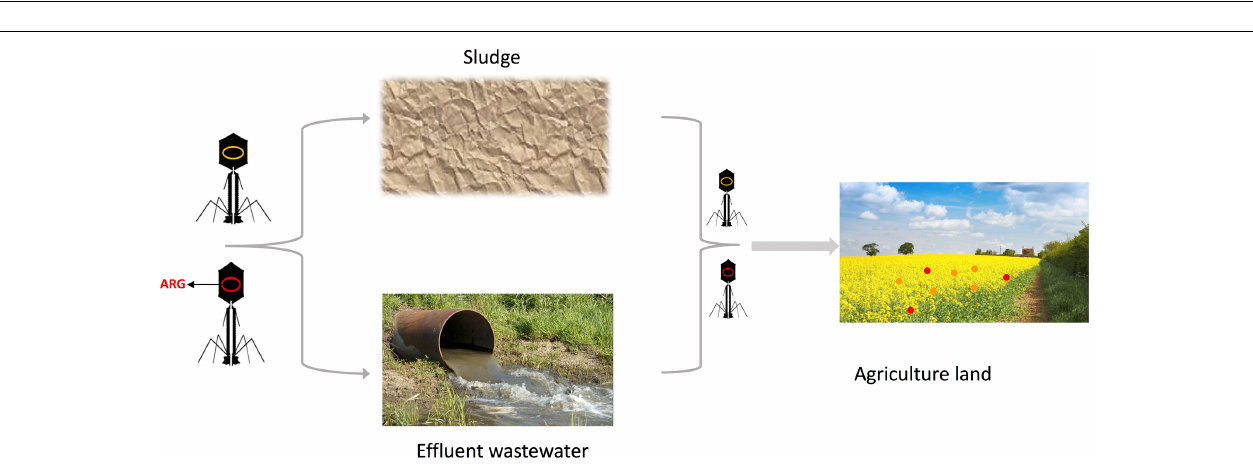
FIGURE 1 | Environmental stress induces transduction events. Environmental factors, including UV light, sub-clinical levels of antibiotics, and other toxic substances will induce SOS responses in bacteria, thus triggering prophage excision (orange) and replication. Phage genetic material will be packaged into the phage particles, as well as random DNA, including Antibiotic Resistance Genes (ARG; red). This increased phage activity will subsequently lead to an increased transduction ratio.